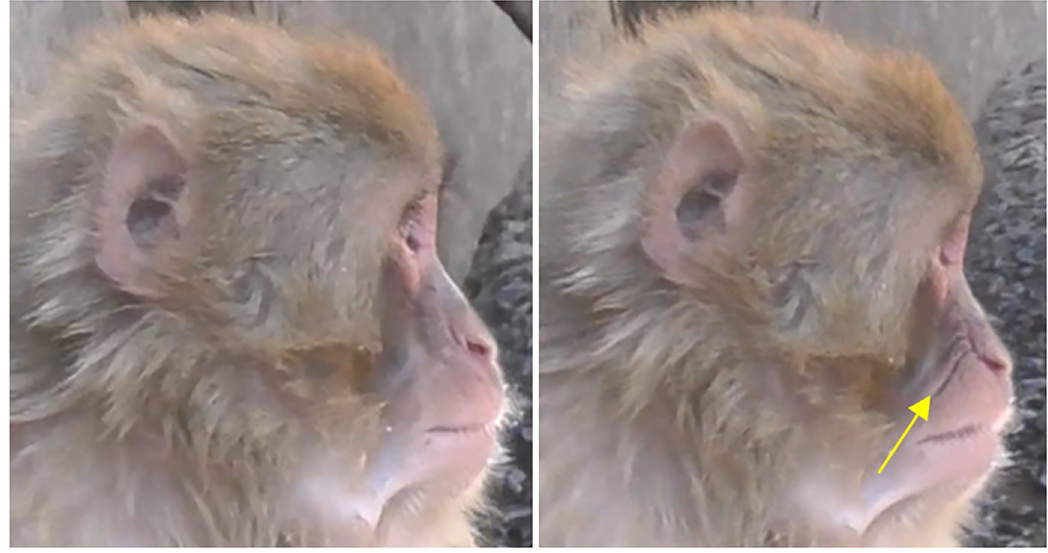
Fig 7. Left: Neutral; Right: AU9 (arrow indicates wrinkles oblique to the nose and shortening of IOT). length vertically (and of the IOT) in the area of the movement is seen and wrinkles form immediately above the lip. The movement of the lip is more oblique than in 9+10, with wrin- kles more perpendicular to the nose right above the lip (Fig 8). The shape of the upper lip may